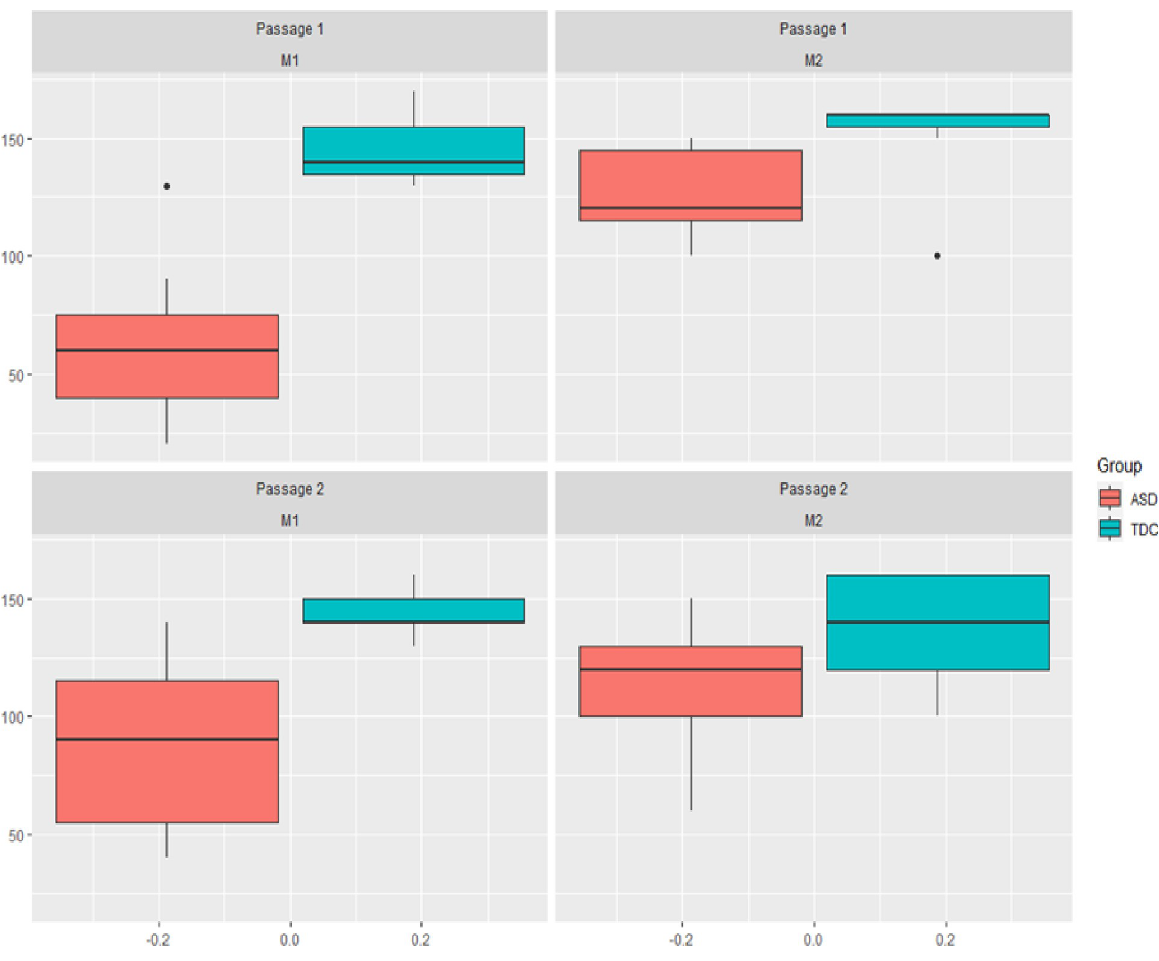
Fig 4. Distribution plots of M1 and M2 during the first and second passages back and forth for ASD individuals and TDCs.